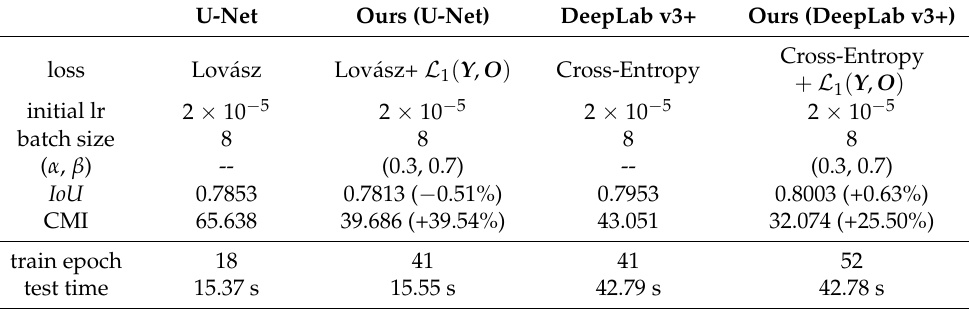
Table 6. Training parameters and quantitative evaluation